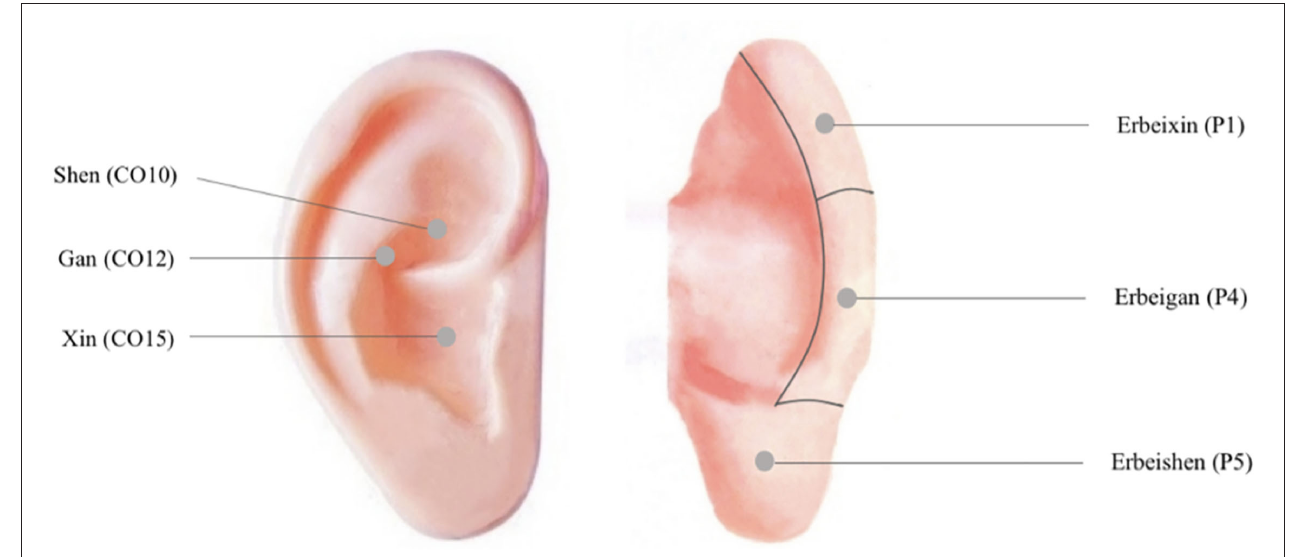
FIGURE 2 | The location of auricular intradermal acupuncture